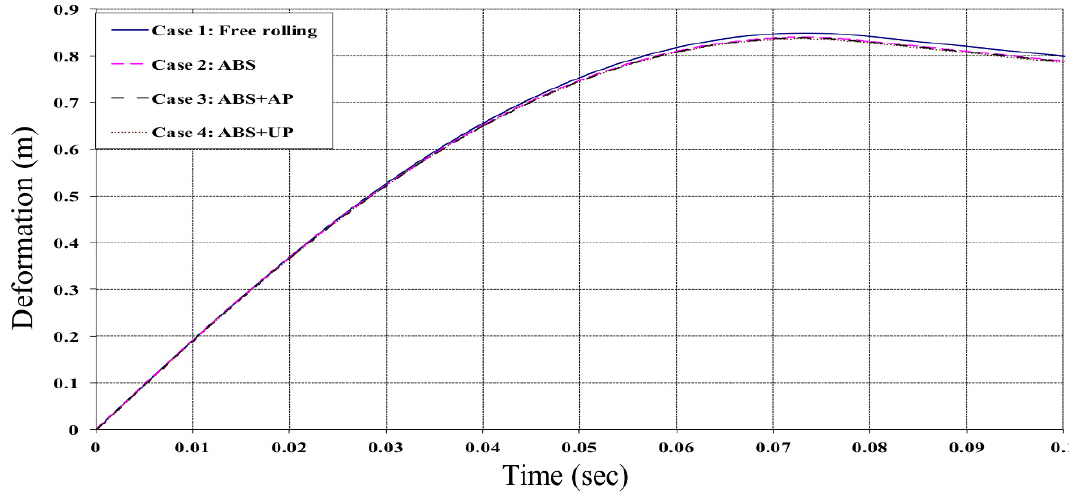
Figure 13. Deformation of the vehicle front-end for all cases at full frontal collision and speed of 70